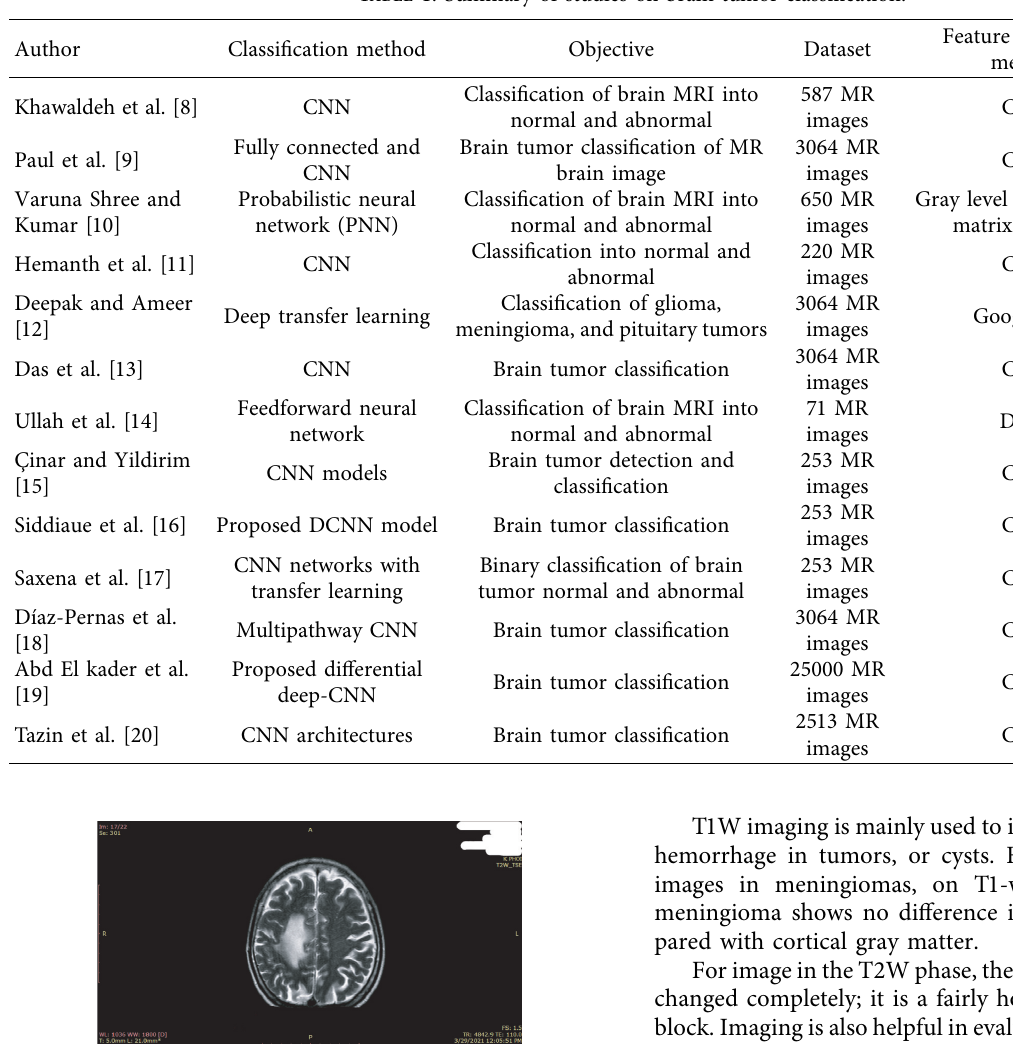
Figure 1: Actual DICOM image (patient information has been removed).